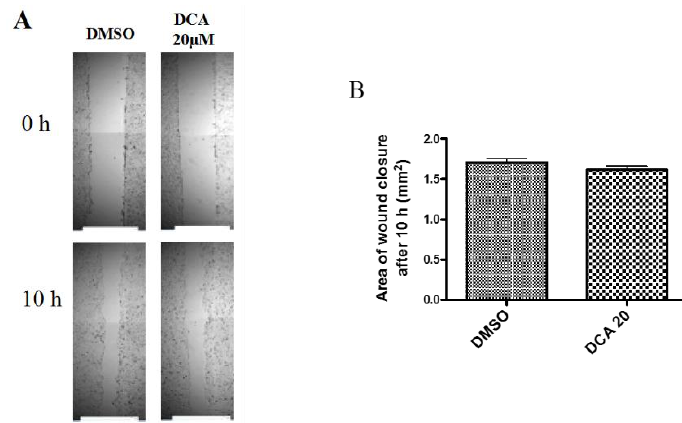
Figure 2. Effect of DCA on 2-D migration. ( A ) Images taken on the Cellavista of the scratch wound at time 0 and after 10 h in DMSO (0.1%) and DCA (20 µ M)-treated cells. ( B ) The corresponding bar graph showing the results of the migration assay. n = 3 for each group .